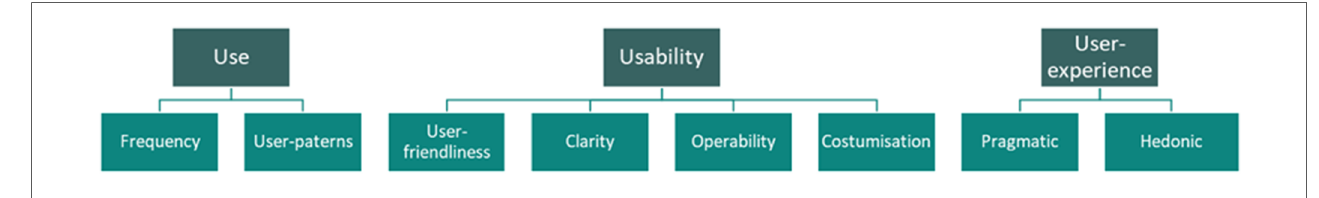
FIGURE 4 Theoretic framework on use, usability and